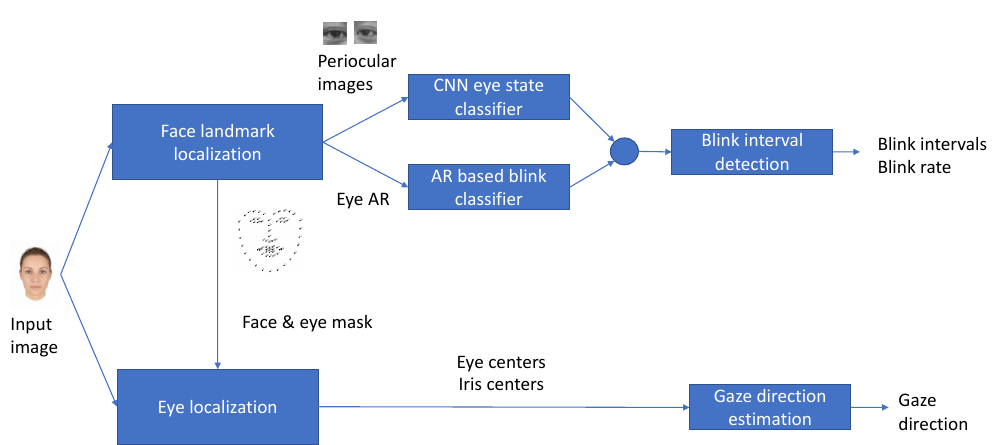
Figure 1. Solution outline. The proposed system analyses two eye features which are accepted as sources as deceit detection: blinks and gaze direction. The blink detection module combines the result of two classifiers to determine the blink intervals. The gaze analysis module determines the position of the iris centers using a shape based method and estimates the gaze direction using the distance and orientation of the eye and iris